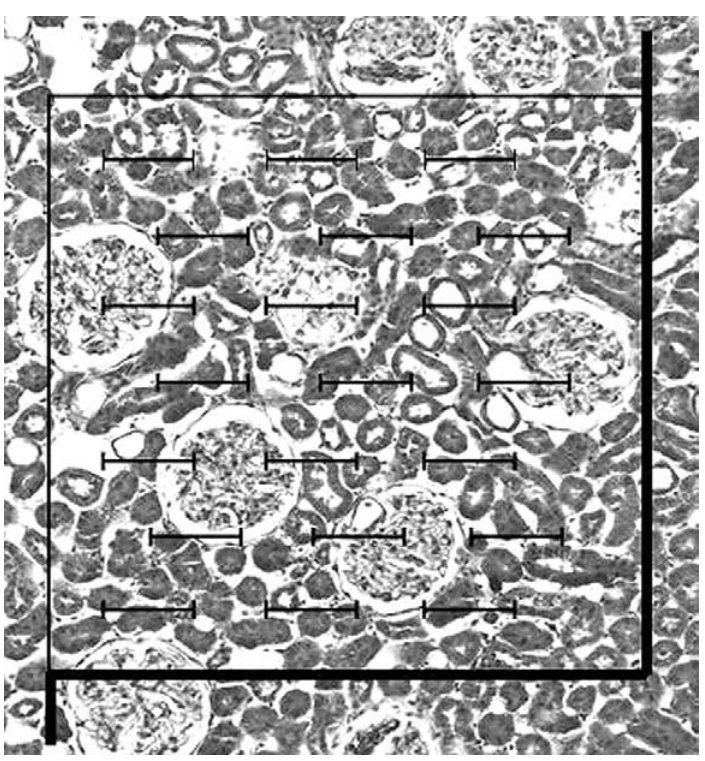
Fig. 14 – Photomicrograph of the renal cortex with the M42 test-system superimposed (see text).